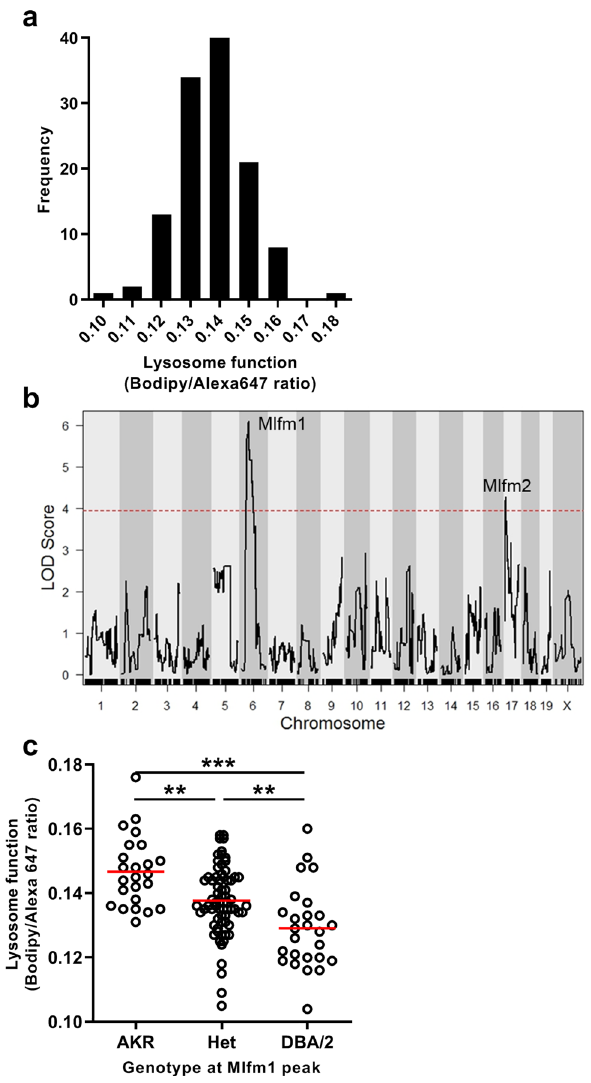
Figure 3. QTL analysis for lysosome function. ( a ) Normal distribution of the Bodipy/Alexa647 fluorescence ratio after F4 BMDM incubation with lysosome function indicator. ( b ) QTL LOD plot for lysosome function showing Mlfm1 and Mlfm2 on chromosomes 6 and 17, respectively. The dashed red line shows the genome-wide p = 0.05 threshold based on 10,000 permutations. ( c ) F4 BMDM lysosome function values by genotype at the Mflm1 peak marker (mean values [red lines]; ANOVA linear trend test r 2 = 0.208, p < 0.0001; **, p < 0.01, and ***, p < 0.001 by ANOVA Tukey posttest). QTL plot prepared using r/QTL 44 , other graphs prepared using GraphPad Prism software v9.0.0 (www. graph pad. com).